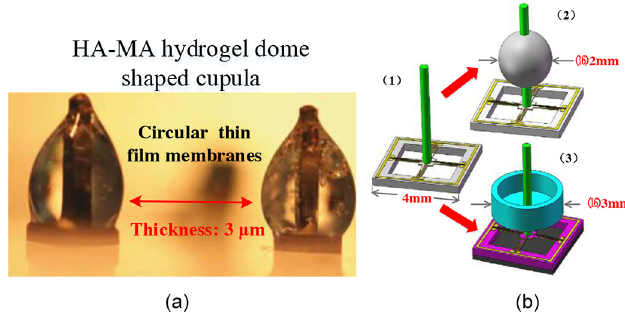
Fig. 2. Biomimetic sensors based on the expanding sensing areas. Table 1. Features of different